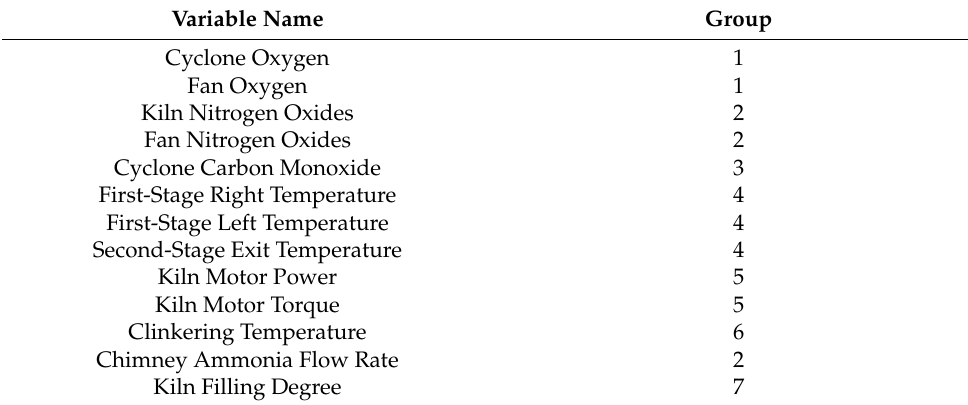
Table 7. Rotary kiln APC system: main CVs grouping